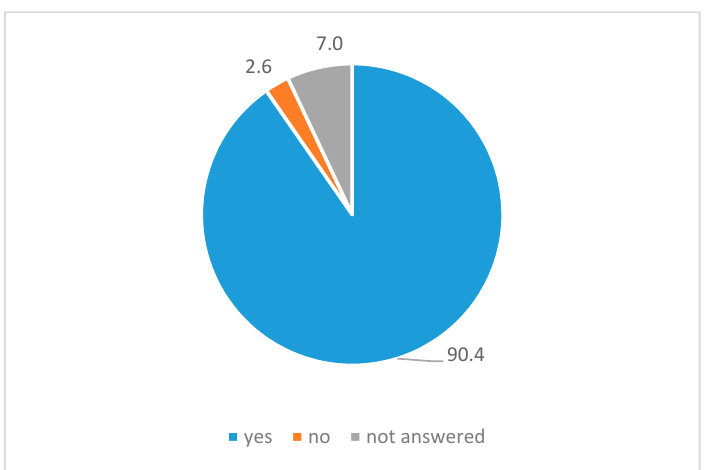
Figure 3. Response rate to the statement “The website addresses problems that relate to me”, in percent, N = 114.